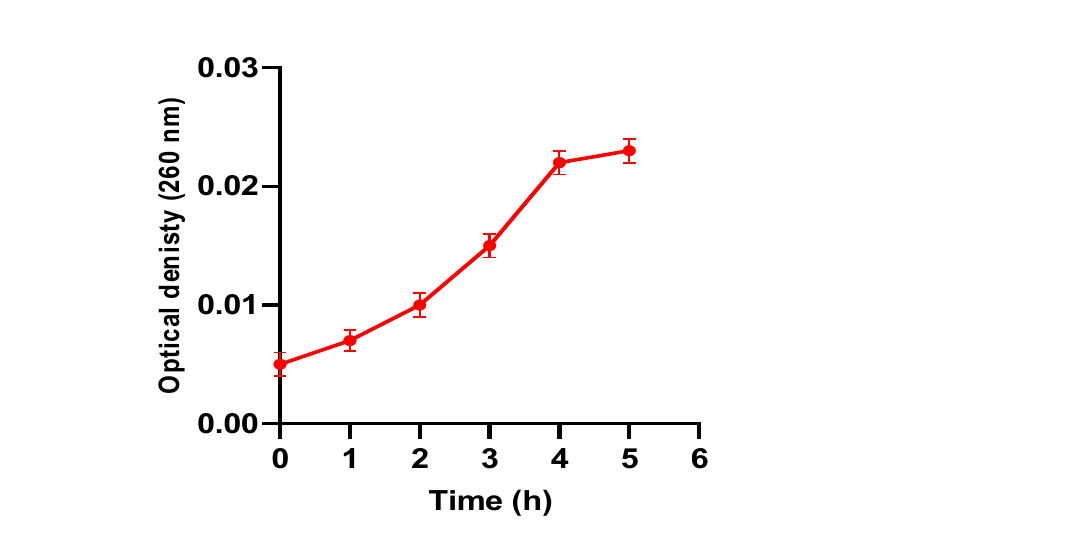
Figure 3. A representative example of the significant decrease ( p < 0.05) in the membrane integrity by EVME by increasing the leakage of nucleic acids.